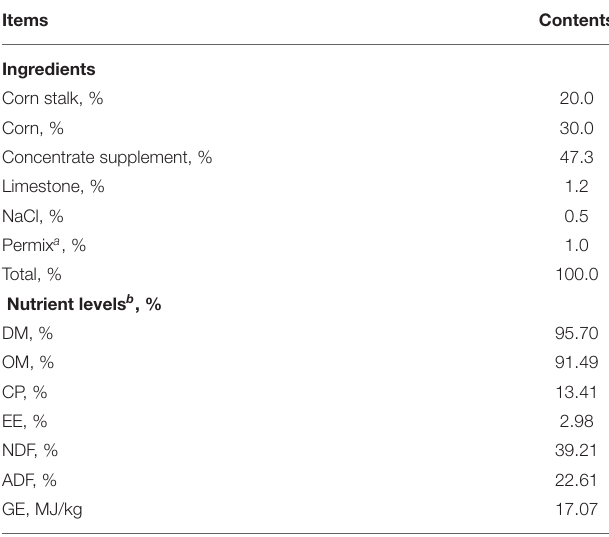
TABLE 1 | Composition and nutrient levels of the basal experimental diets (DM basis).